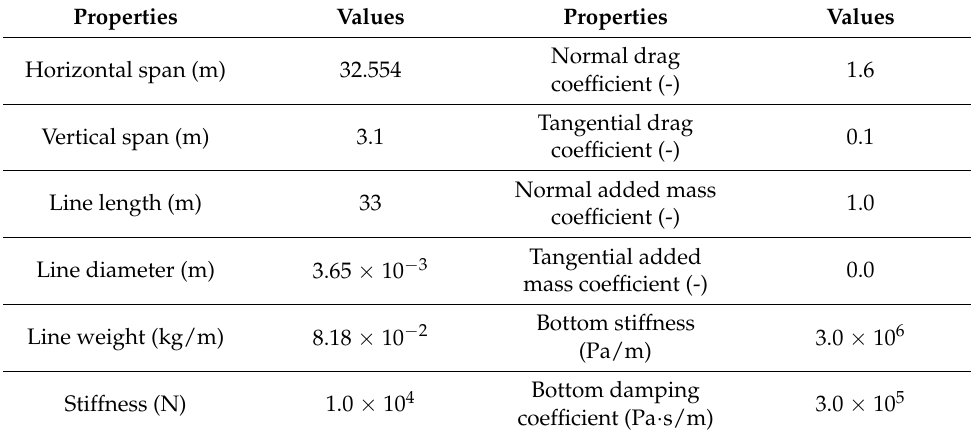
Figure 6. Experimental setup for a dynamic load test. Table 1. Properties of mooring line for dynamic load.